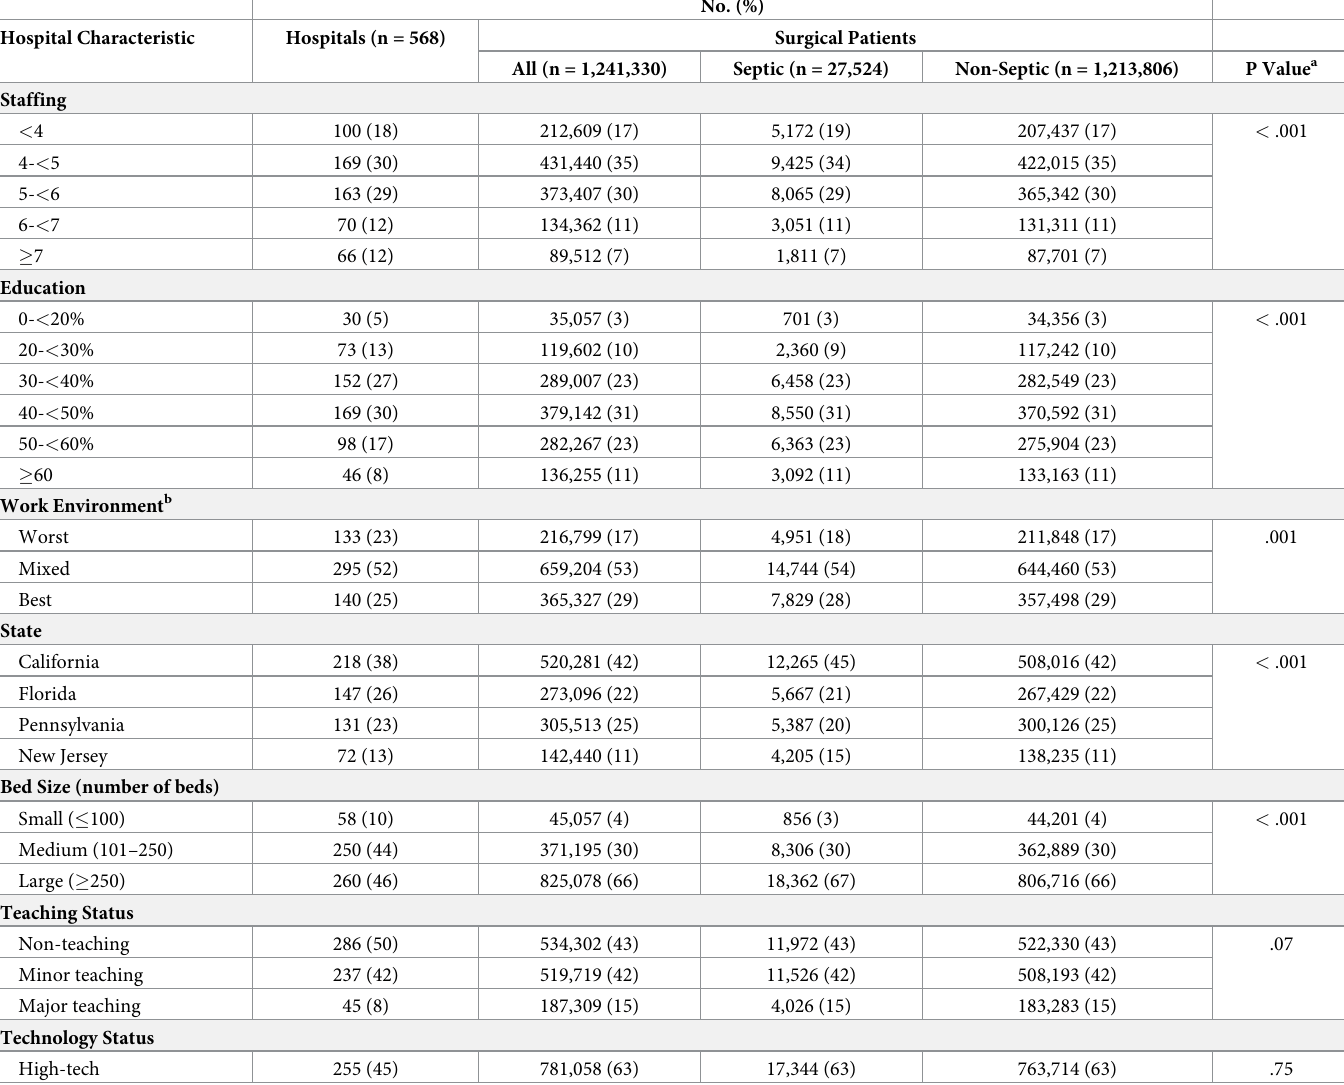
Table 2. Study hospitals and surgical